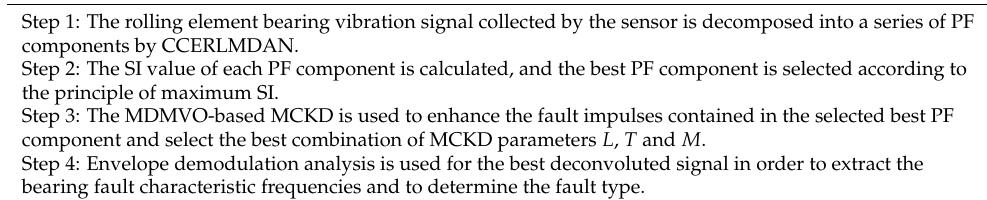
Algorithm 3. CCERLMDAN and MDMVO-based MCKD